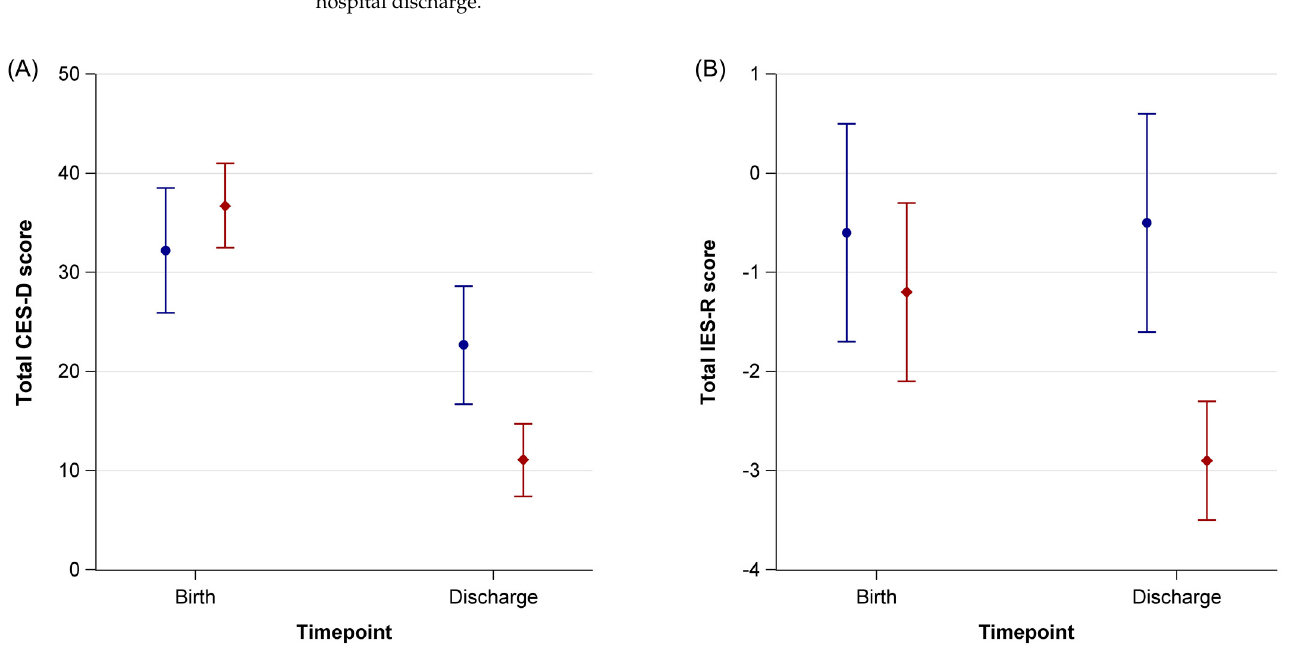
Figure 2. Total CES-D scores ( A ) and total IES-R scores ( B ) of mothers of preterm infants born < 32 gestational weeks with music therapy (red diamonds) and without music therapy (blue circles) one week after birth and at the infants’ discharge from hospital. Error bars represent 95% confidence intervals.